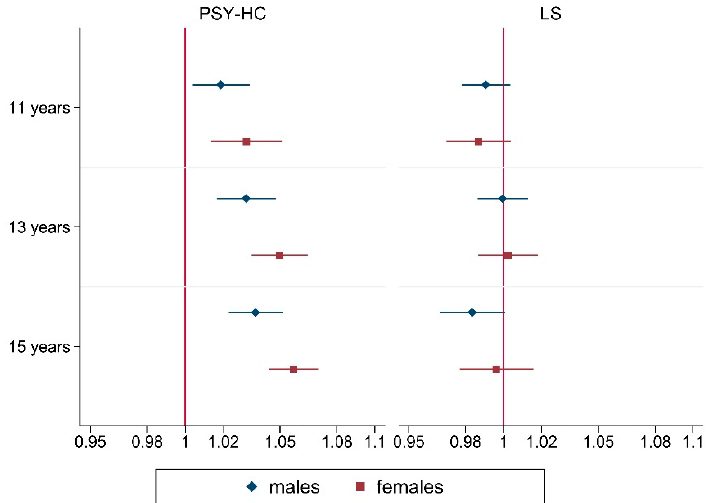
Figure 2. Yearly adjusted trends of PSY-HC and LS from 2010 to 2018, stratified by gender and age groups. Results from multivariable logistic regression (OR (95%CI)). Abbreviations. LS: life satisfaction ≥ 9; PSY-HC: ≥ 2 psychological health complaints more than once a week. Adjustment variables: